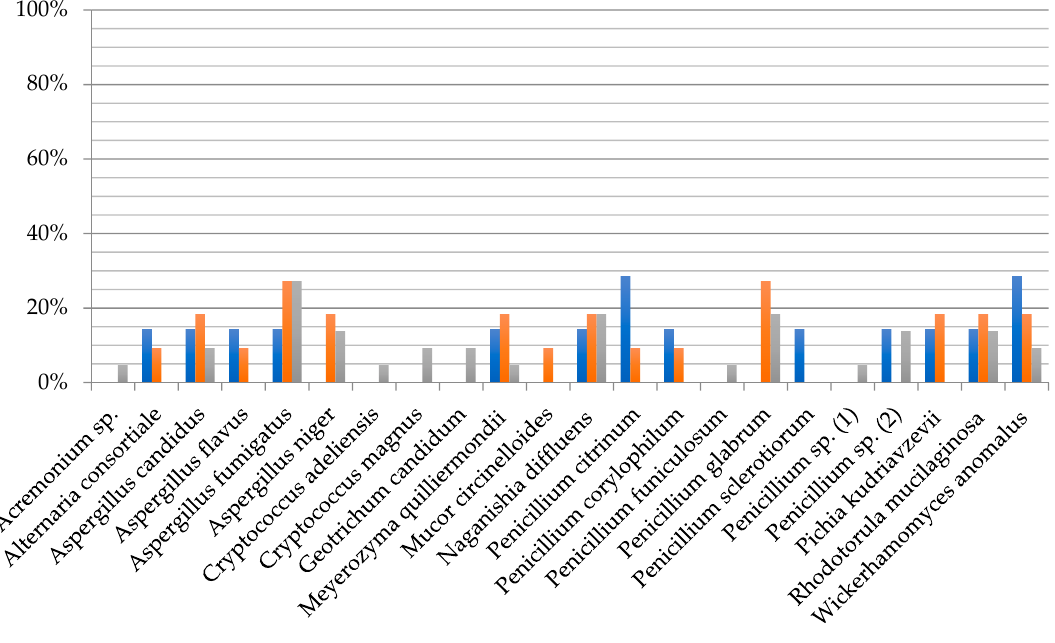
Figure 8. Frequency of the occurrence of fungi on the surface of human feet skin depending on the physical activity frequency of examined people.